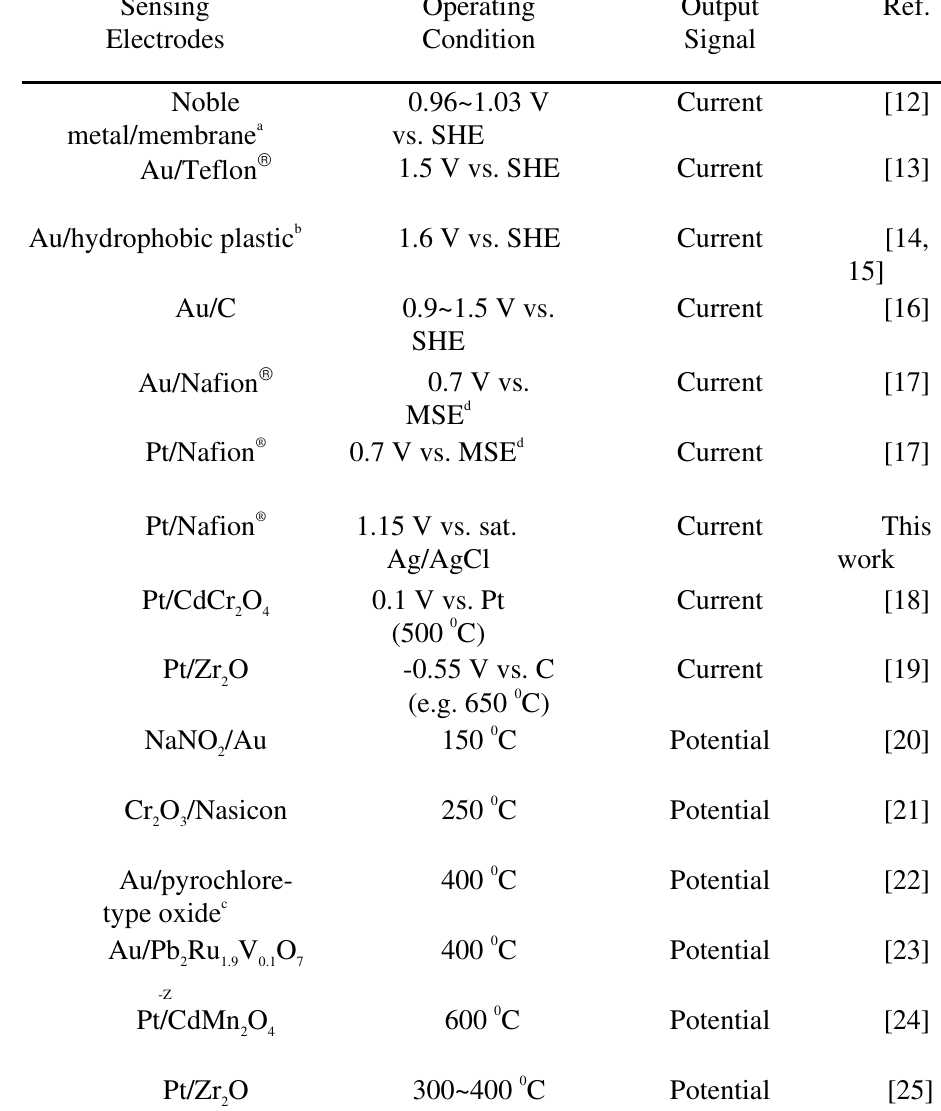
Table 2 . The operating condition and output signal for NO sensing concentration studied in the gas phase at various